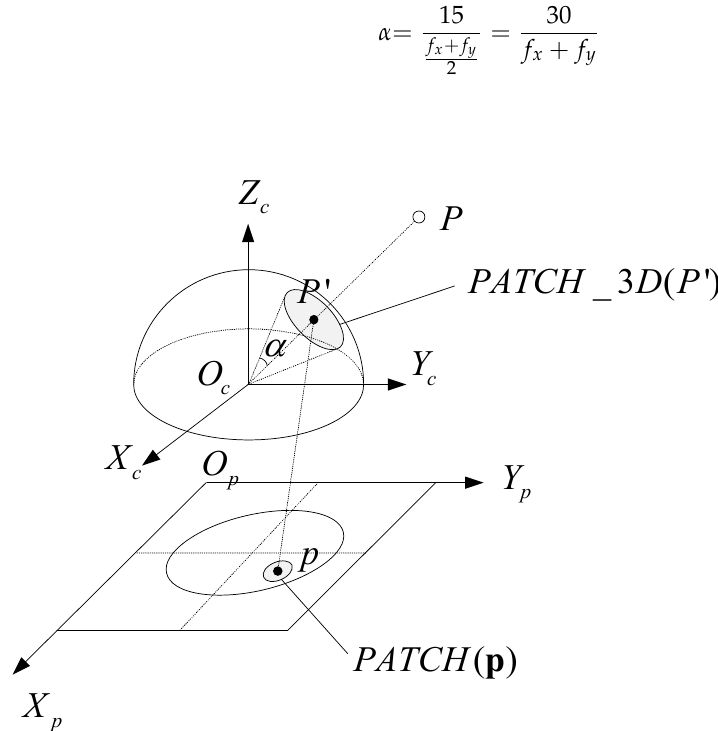
Figure 2. The circle area for 3D gray centroid calculation on the unit spherical surface and its projection area in the fisheye image